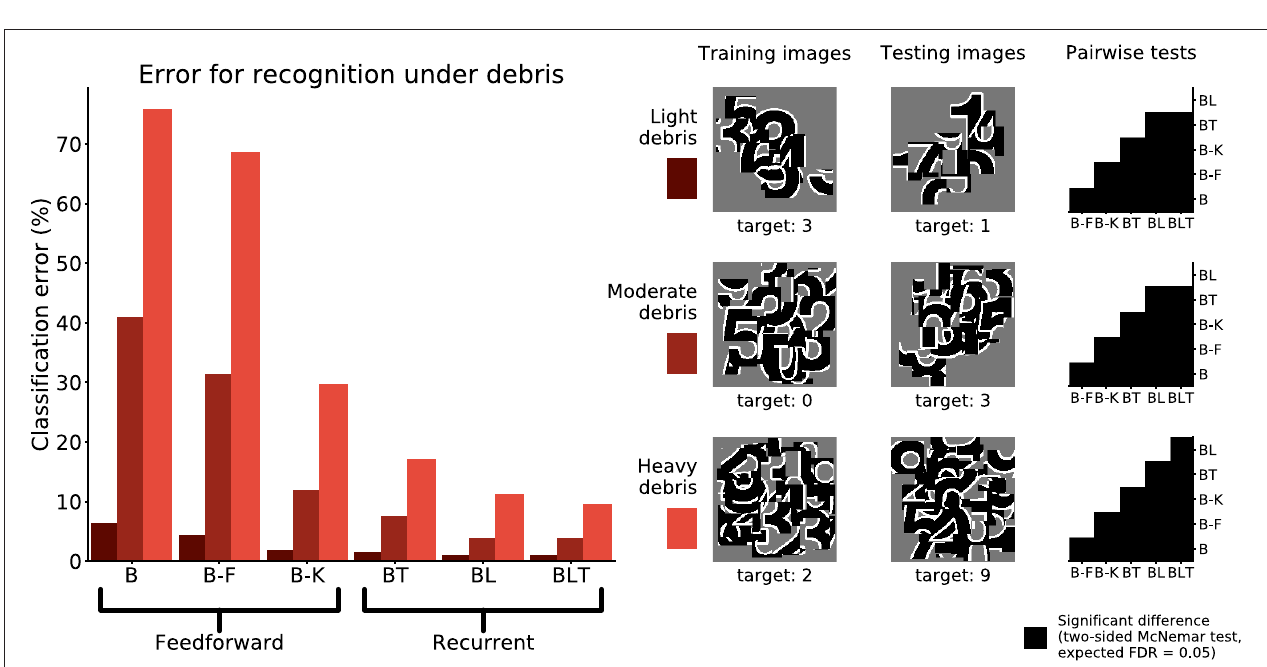
FIGURE 5 | Classification error for all models on single digit detection under varying levels of debris. Examples of the images used to train and test the networks are also shown. Matrices to the right indicate significant results of pairwise McNemar tests. Comparisons are across models and within image sets. Black boxes indicate significant differences at p < 0.05 when controlling the expected false discovery rate at